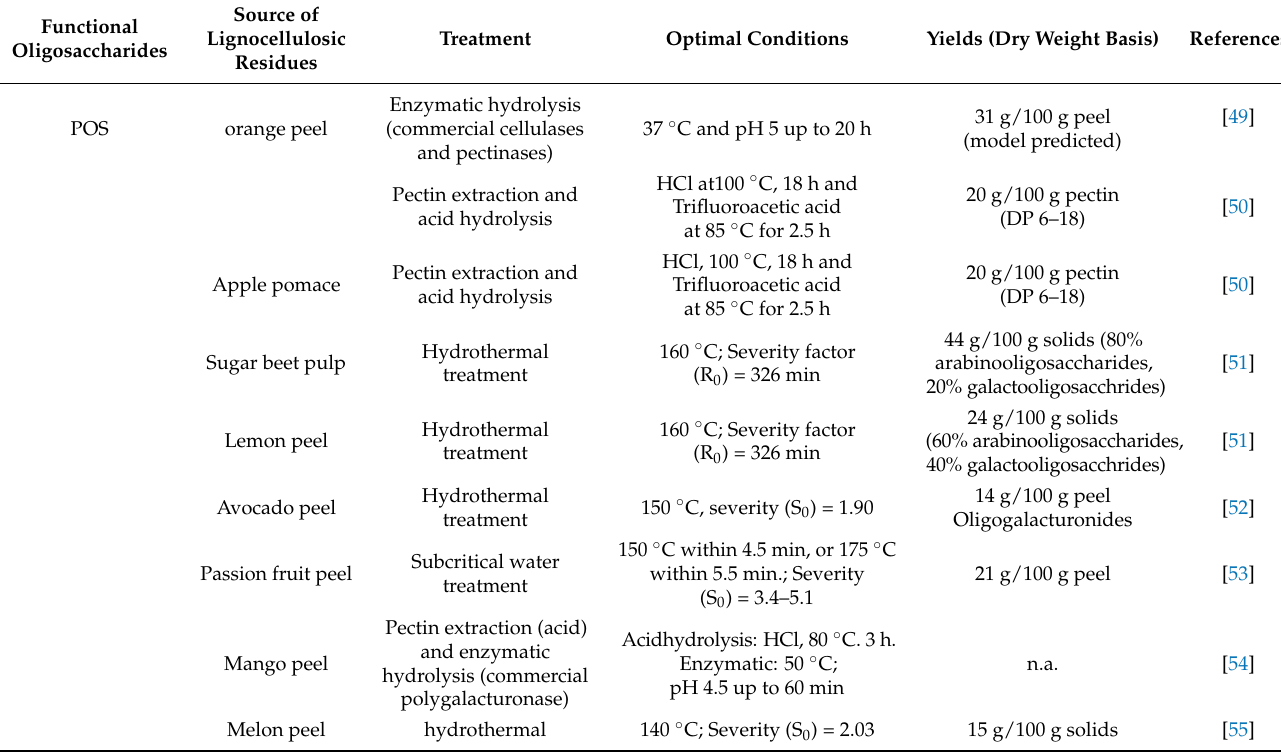
Table 3. Main functional oligosaccharides derived from fruit-and-vegetable solid by-product and waste streams: sources, processes and